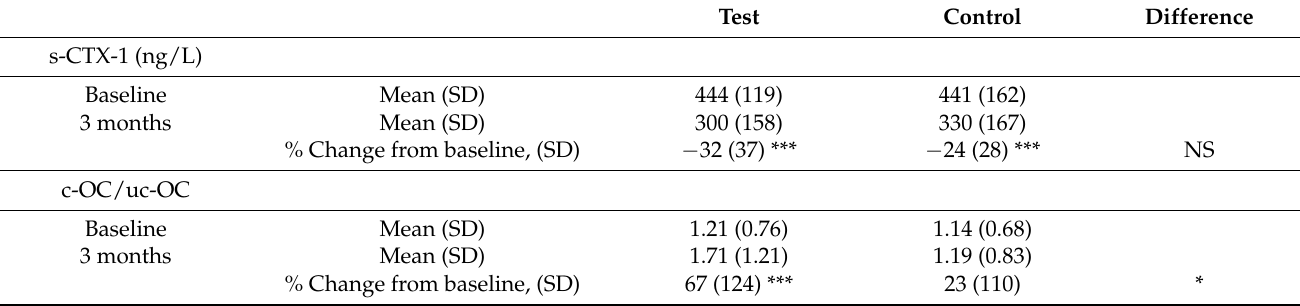
Table 5. Changes in bone metabolism parameters (secondary endpoints) in response to test and control products over six